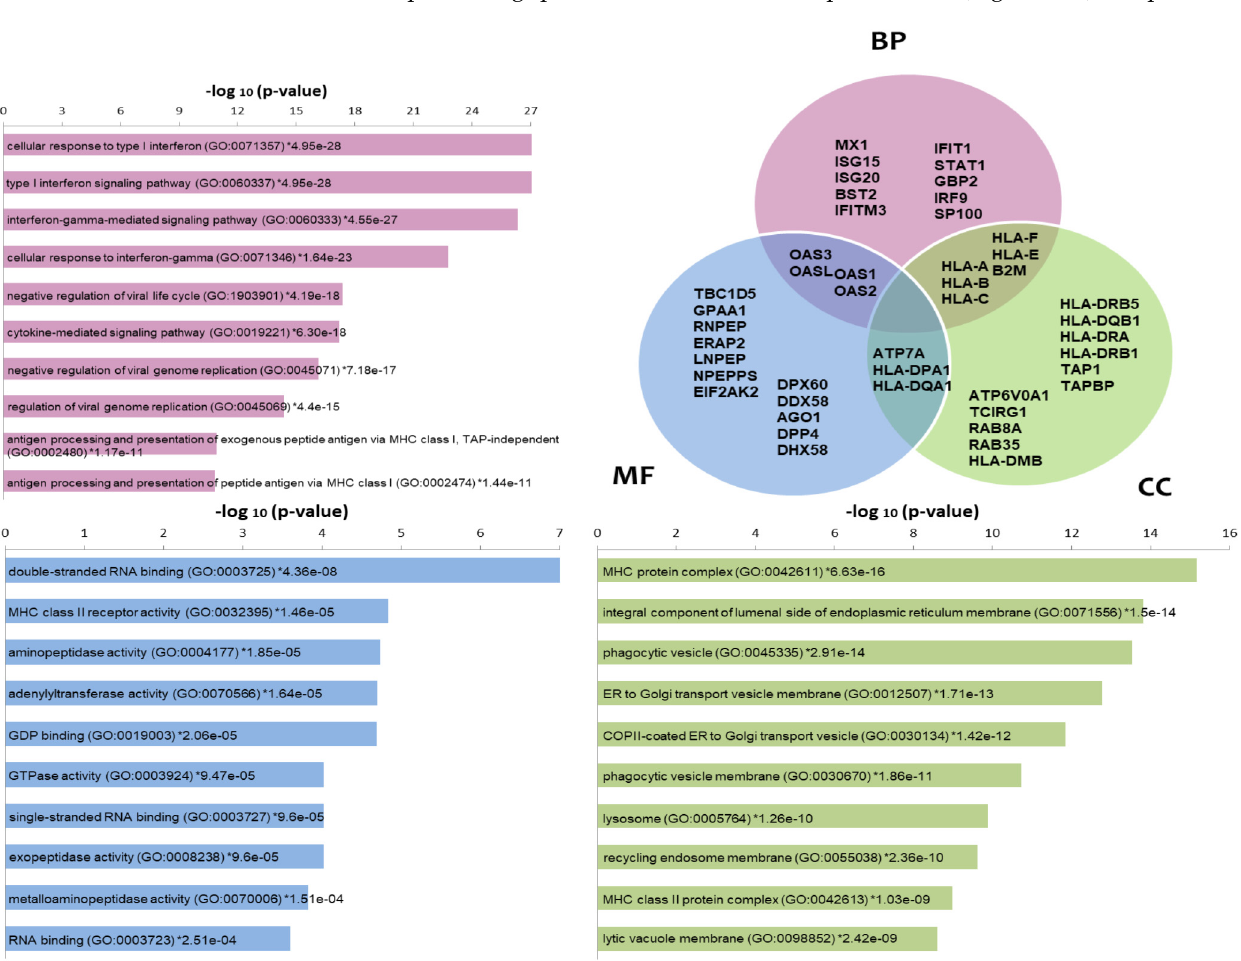
Figure 2. Enrichment analysis of proteomic data using the Enrichr tool. The most commonly enriched terms − log10 ( p -values)) in the list of differentially expressed proteins are shown in the categories Biological Processes (BP), Molecular functions (MF) and Cellular components (CC) as bars. A Venn diagram is also used to indicate some of the proteins included in the categories as well as those common among categories. Gene symbols are used in the Venn diagram.